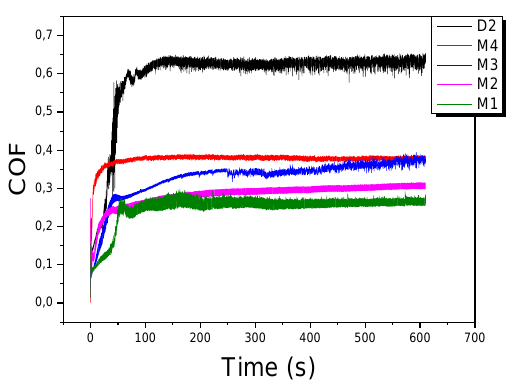
Figure 7. Coefficient of friction versus time for the carbides deposited on AISI D2.